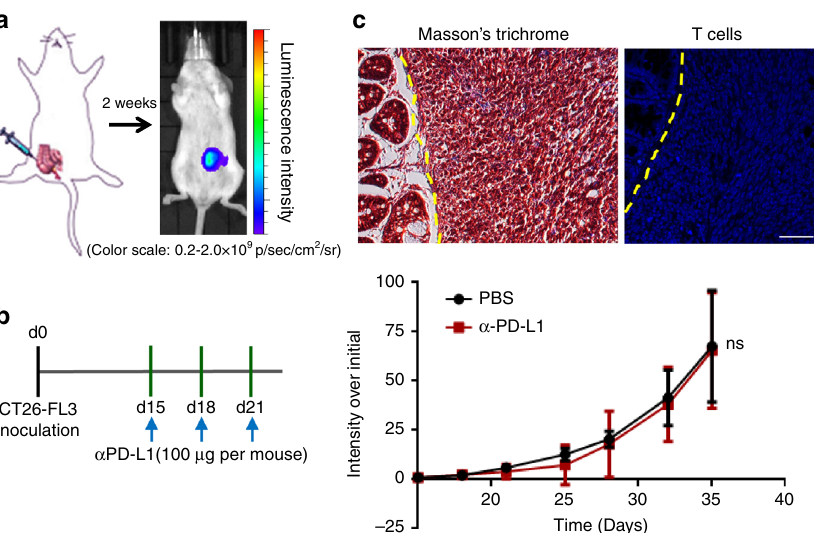
Fig. 1 Orthotopic CT26-FL3 tumor is resistant to anti-PD-L1 mAb therapy. a Establishment of orthotopic colorectal tumor models. CT26-FL3 (RFP/Luc) cells were inoculated into the mouse cecum wall, and the tumor burden was monitored by bioluminescent analysis. b Treatment scheme and tumor growth curves of orthotopic CT26-FL3 tumors in PBS and α -PD-L1 treated groups ( n = 5 mice per group). c Masson ’ s trichrome and immuno fl uorescence staining of orthotopic CT26-FL3 tumor tissues in PBS group using 4 ′ ,6-diamidino-2-phenylindole (DAPI, blue) and anti-CD3 antibody (red). Yellow dotted line indicates the border between intestinal mucosa and the orthotopic tumor. Scale bar represents 50 μ m. Signi fi cant differences were assessed in b using two-way ANOVA. Results are presented as mean (SD). ns, not signi fi